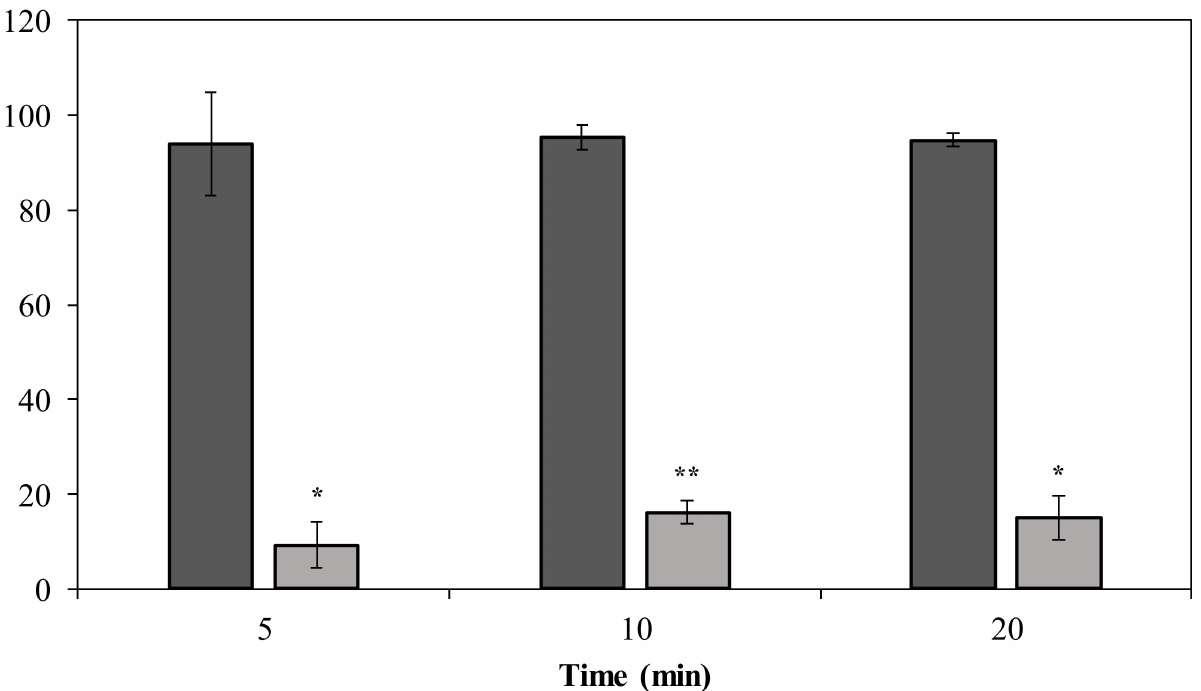
Figure 8. Phage MK34 adsorption after capsule removal. Intact (dark grey) and 1.32 µ M DpoMK34 treated (light grey) A. baumannii MK34 cells were used for an adsorption assay by incubating expo- nentially growing cells with phage MK34 at MOI of 0.01. Bars represent means ± standard deviation of three independent replicates. Asterisks show statistical differences compared to phage MK34 adsorption to intact A. baumannii MK34 cells (Student’s t -test; * p < 0.01, ** p <